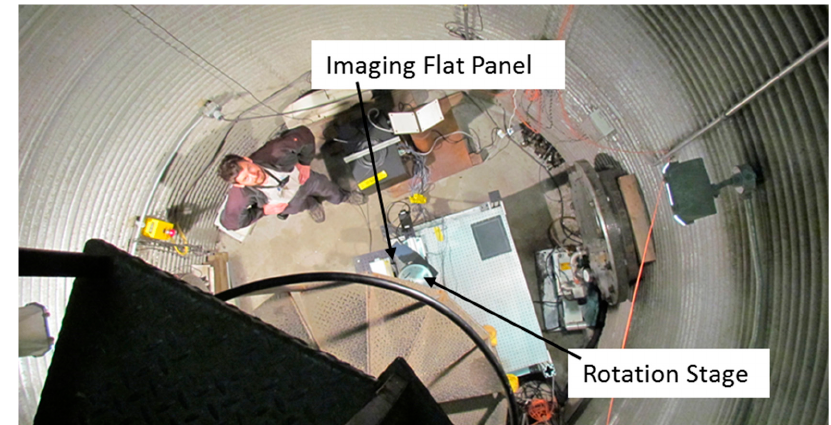
Figure 5. James Hunter standing at the bottom of the “Silo”, the 60 m experimental station on 1FP-05. The neutron beam enters from the right. A flat panel imaging set up is at center, partially obscured by the spiral staircase. This station is located about 9 m underground.